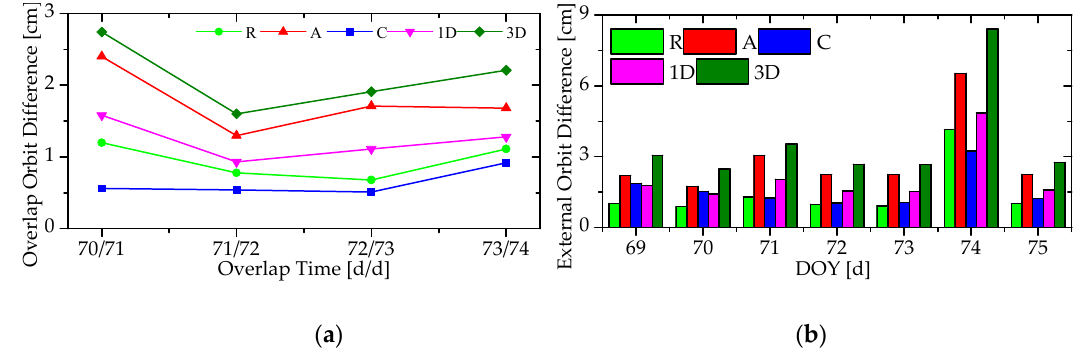
Figure 1. The post orbit accuracy assessment of the FY3C satellite using dual-frequency carrier-phase and pseudo-range measurements in 2015/69 − 75: ( a ) The RMS statistics of the radial (R), along-track (A), cross (C), 1-dimensional (1D) and 3-dimensional (3D) orbit difference in the 5h-overlap arcs; ( b ) The daily RMS statistics of the R/A/C/1D/3D orbit difference from external precise orbit products. For the YG30/SAT1 − SAT6 satellites, it is difficult to obtain high-precision post POD orbits with accuracies at the centimeter level, because the space-borne GPS/BDS receivers only provide single-frequency pseudo-range data. It seems impossible to assess the absolute accuracy of the post POD orbits, due to lack of external precise orbit products. The RMS statistics of the overlap orbit differences of the YG30/SAT1 − SAT6 satellites are all shown in sub-graph (a) and (b) of Figure 2. As a comparison, the RMSs of overlap and external orbit differences of the FY3C satellite are also illustrated in sub-graph (c) and (d), where the precise orbits are generated by using only single-frequency pseudo-range measurements. As can be observed from sub-graphs (c) and (d), the RMSs of 1D and 3D overlap orbit differences of the FY3C satellite are about 4 − 7 cm and 7 − 11 cm, respectively, and those of 1D and 3D external orbit differences 5 − 8 cm and 12 − 14 cm, respectively. Sub-graphs (a) and (b) illustrate the RMSs of overlap orbit differences of SAT1-SAT6 satellites are all of similar magnitude, and the 1D and 3D differences are about 7 − 11 cm and 10 − 20 cm, respectively. It may be possible to give an external accuracy indicator for the YG30 series satellites by applying an RMS ratio parameter of FY3C satellite. The FY3C RMS ratio is defined as the ratio of the RMS of the external orbit differences over the RMS of the overlap orbit differences. If the YG30 series satellites are assumed to have the same RMS ratio of the FY3C satellite, then the RMSs of the “external” orbit differences of the YG30 series satellites are inferred from the RMSs of the overlap orbit differences, even if the external orbits of STA1 − SAT6 satellites don’t exist.